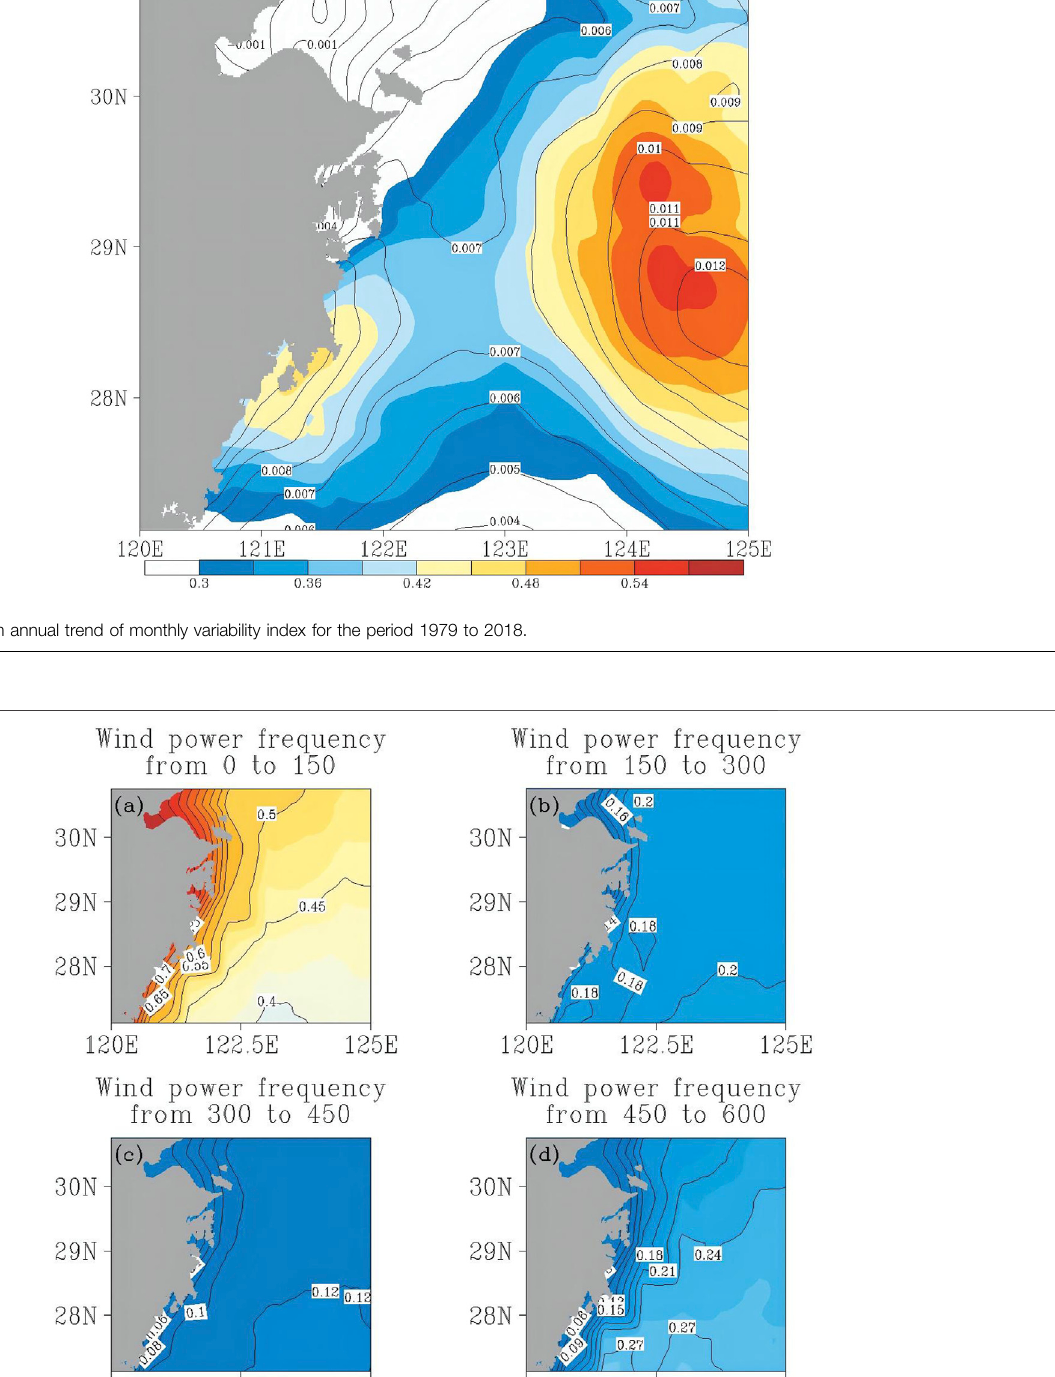
Frontiers in Physics |